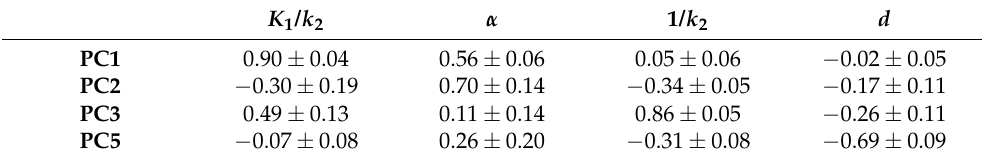
Table 1. Spearman’s correlation coefficients (median ± median absolute deviation) of all PC / kinetic parameter pairs computed voxelwise for each of the 13 evaluation patients taken